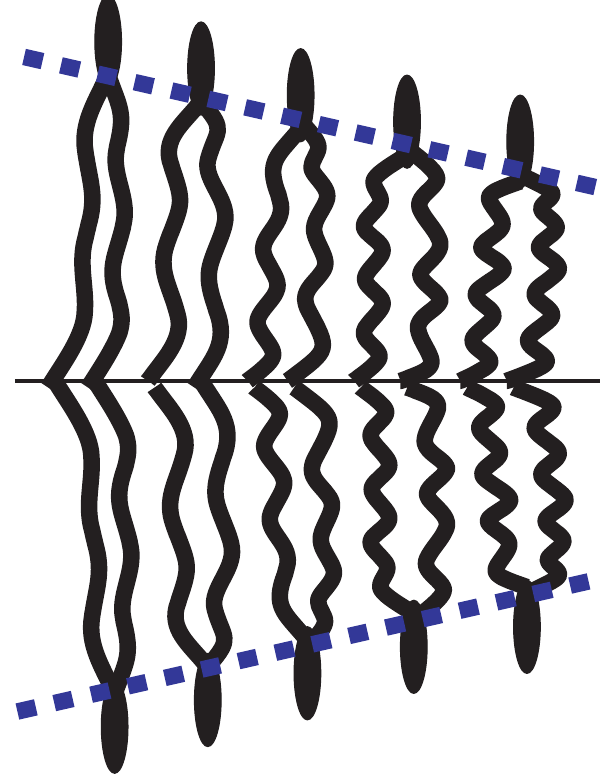
Figure 2. Thickness gradient. Cut of a bilayer membrane with a symmetric thickness gradient. The dashed blue lines correspond to the hydrocarbon-water interfaces.